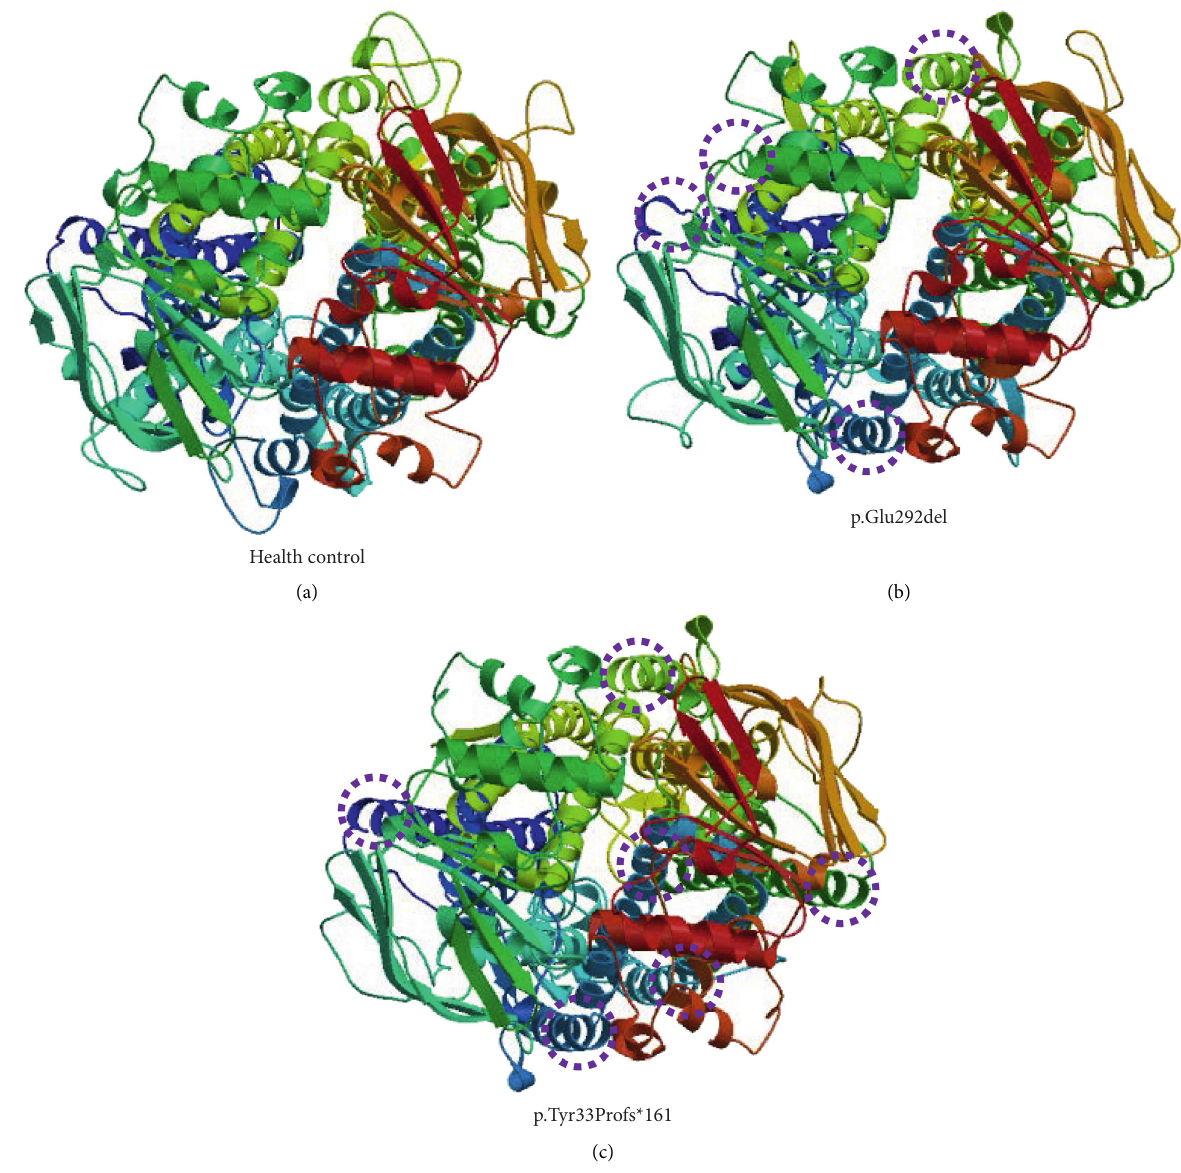
Figure 3: Three-dimensional structure prediction of adrenoleukodystrophy (ALD) protein. (a) The modeled structure of health control. The visible alteration of ALD protein structure induced by mutations (b) c.874_876delGAG (p.Glu292del) and (c) c.96_97delCT (p.Tyr33Profs ∗ 161) are indicated in circles. It indicates that those mutations might lead to alteration of the protein structure and potential